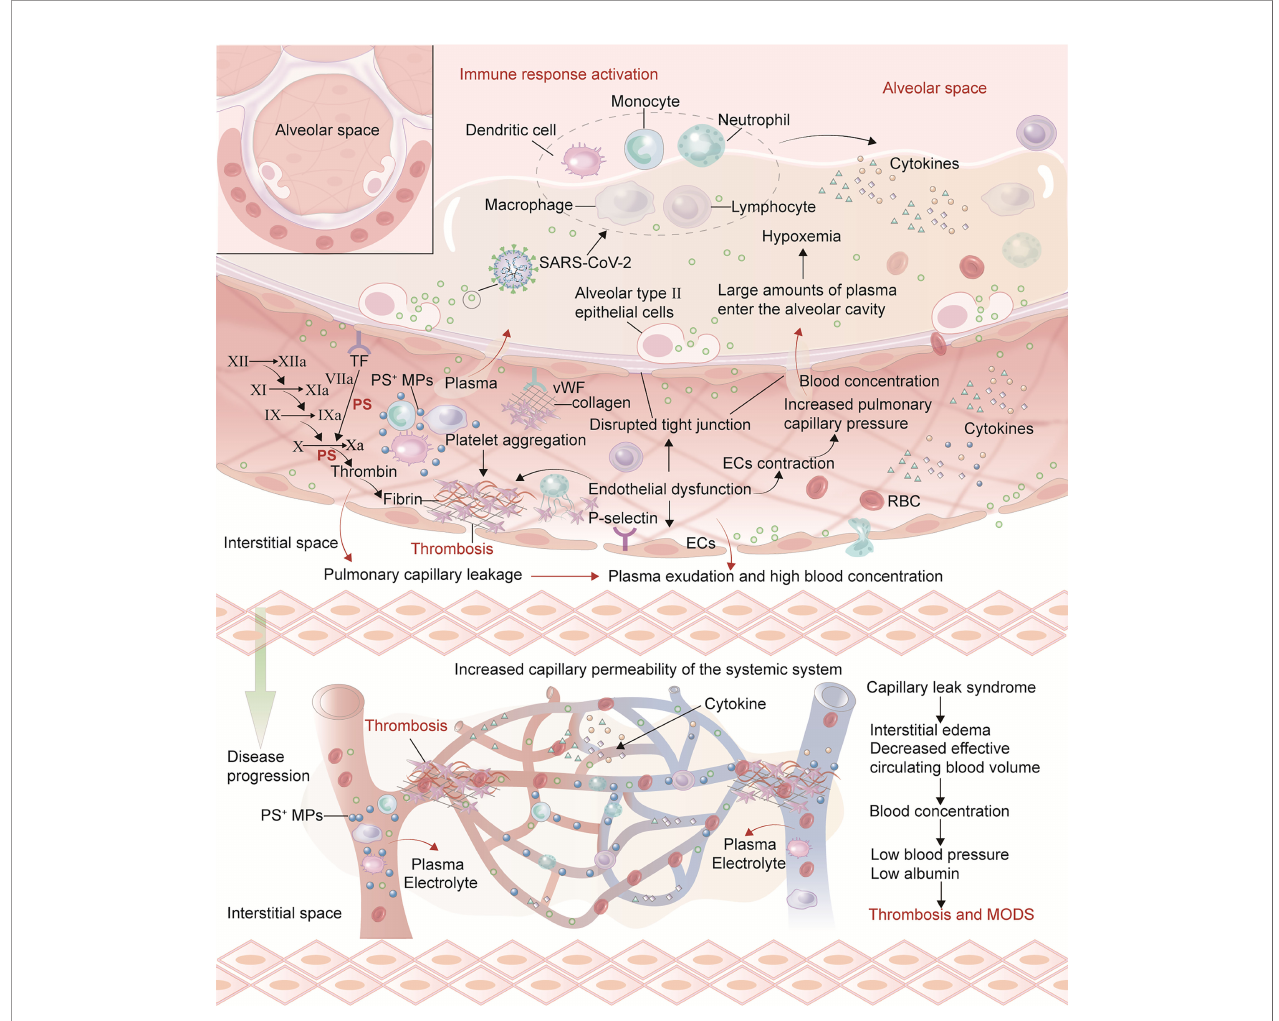
FIGURE 2 | Mechanisms of endothelial injury promoting thrombosis and CLS in acute COVID-19 and long COVID. After vascular endothelial injury, there may be weakened anticoagulant properties, increased permeability and leukocyte adhesion. TF expression on ECs surface is up-regulated. Antithrombin III, TF pathway inhibitor and protein C system are damaged and lose anticoagulant properties. Injured ECs can release vWF, factor VIII and PS exposure to promote a hypercoagulable state. Furthermore, ECs can increase the expression of chemokines on their surface, promote neutrophil recruitment, and participate in thrombosis. SARS-CoV-2 and cytokines (such as TNF- a , IL-1, IL-6) damage the vascular endothelium, resulting in ECs contraction, connections separating and the appearance of intracellular gaps. The general increase in capillary permeability forms a local or SCLS. The increased permeability of pulmonary capillary endothelial injury can lead to plasma entering the alveolar cavity and form hypoxemia. Furthermore, hypoxia aggravates the contraction of pulmonary capillary ECs which thicken and narrow the capillaries, ultimately causing pulmonary hypertension. The plasma and some erythrocytes in the pulmonary capillaries are pushed into the alveolar space, further aggravating respiratory dysfunction and ARDS. As the disease progresses, injury to circulating blood cells and vascular endothelium can activate cytokines release, resulting in extensive capillary ECs damage, increasing the transport channel diameter and vessels permeability, and albumin leakage in the blood